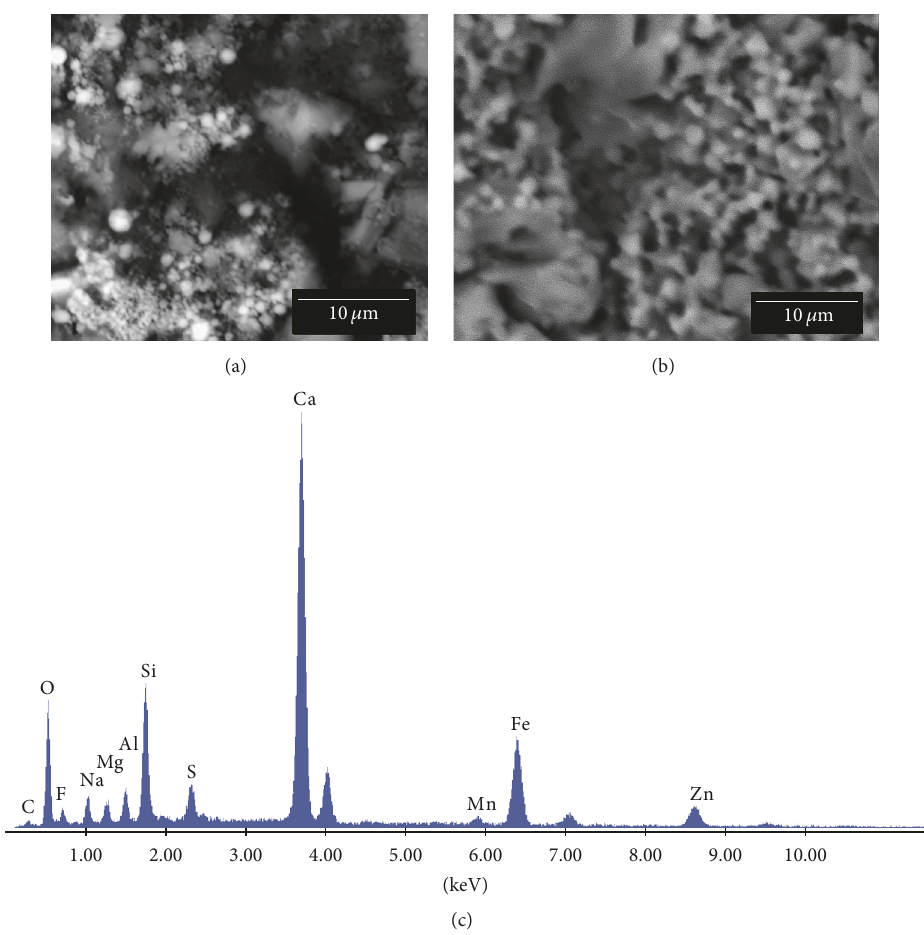
Figure 5: SEM images of two EAFD-FA-LFS samples sintered at 950 ∘ C (a) and at 1150 ∘ C (b). The EDS spectrum (c) was taken from the sample area included in image